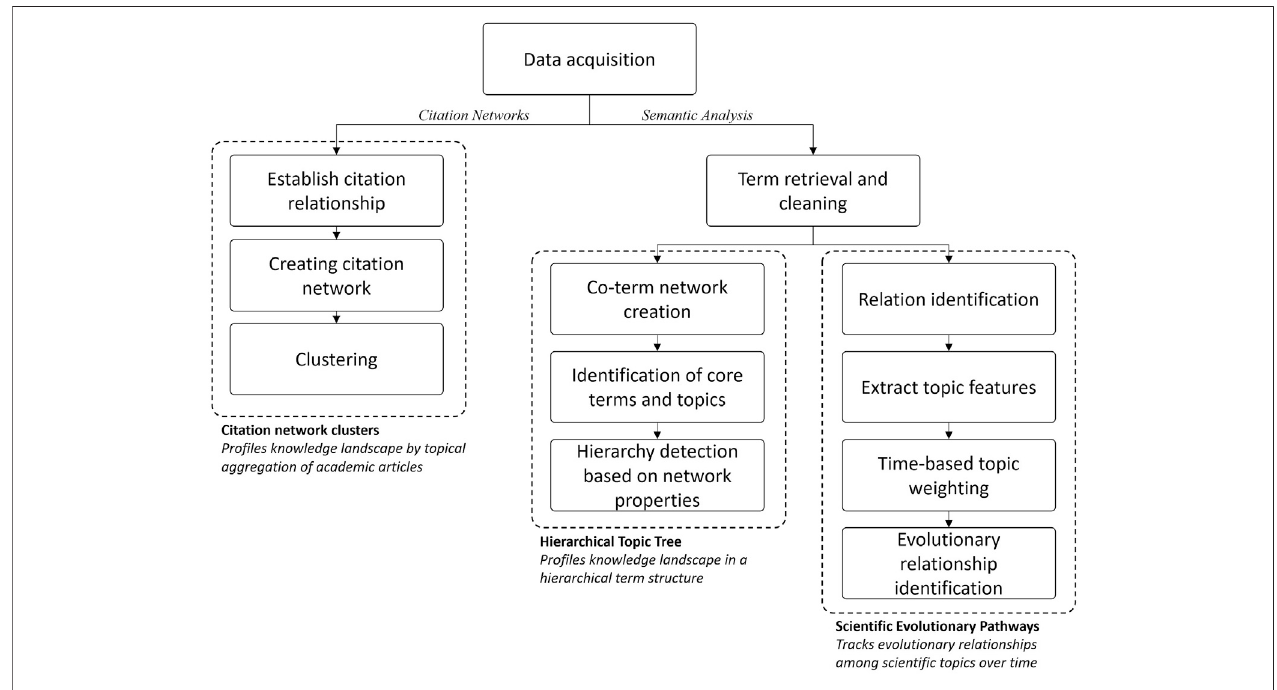
FIGURE 1 | Research